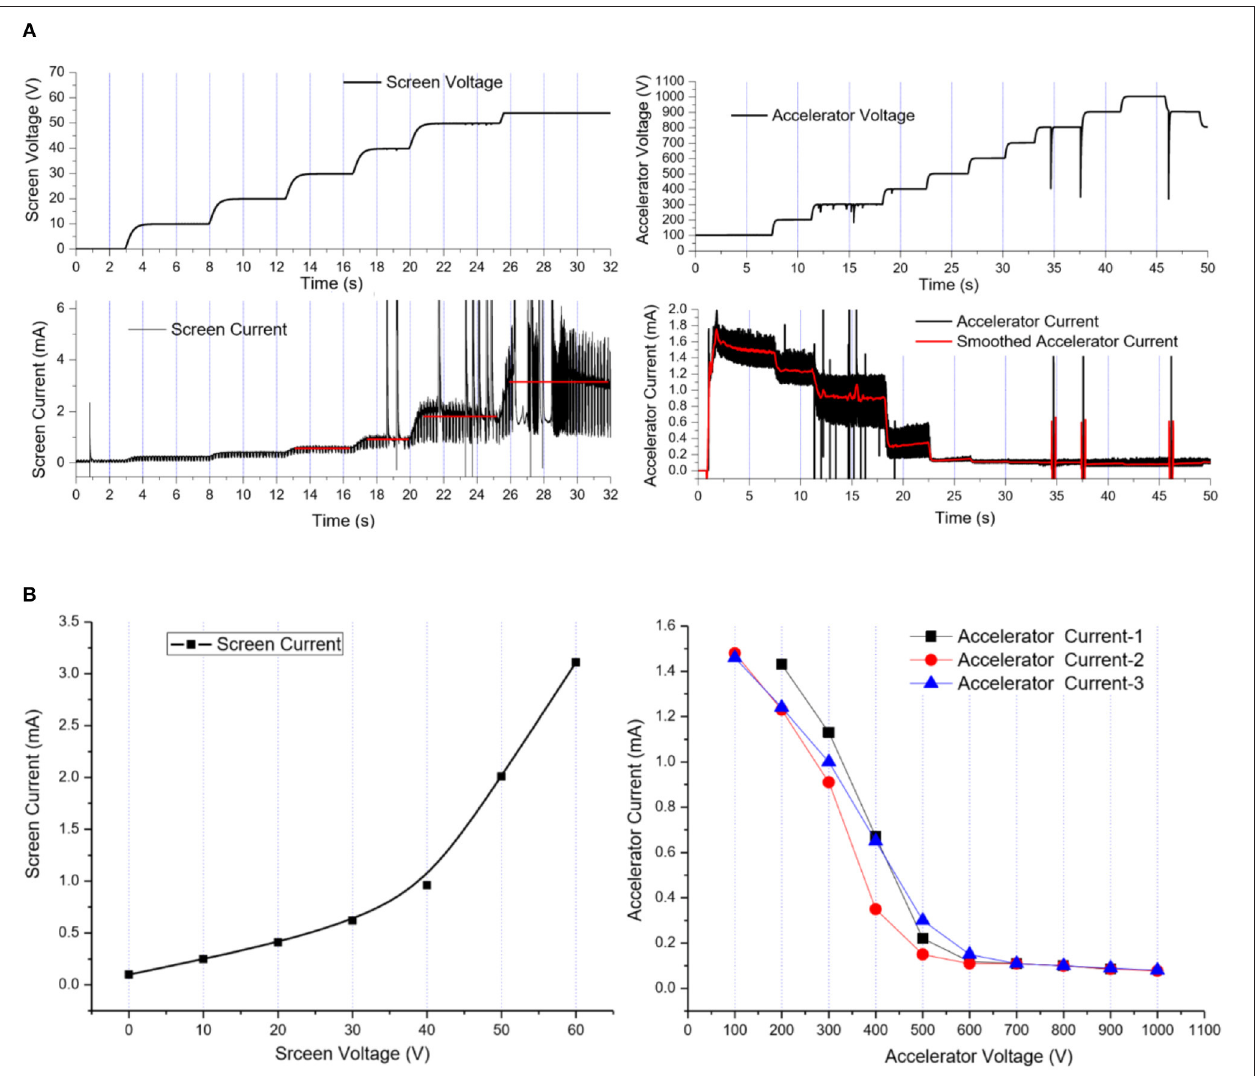
FIGURE 13 | (A) Screen and Accel grids’ voltages and currents during the helicon thruster test and (B) currents vs. voltages for screen and accel grids during the helicon thruster